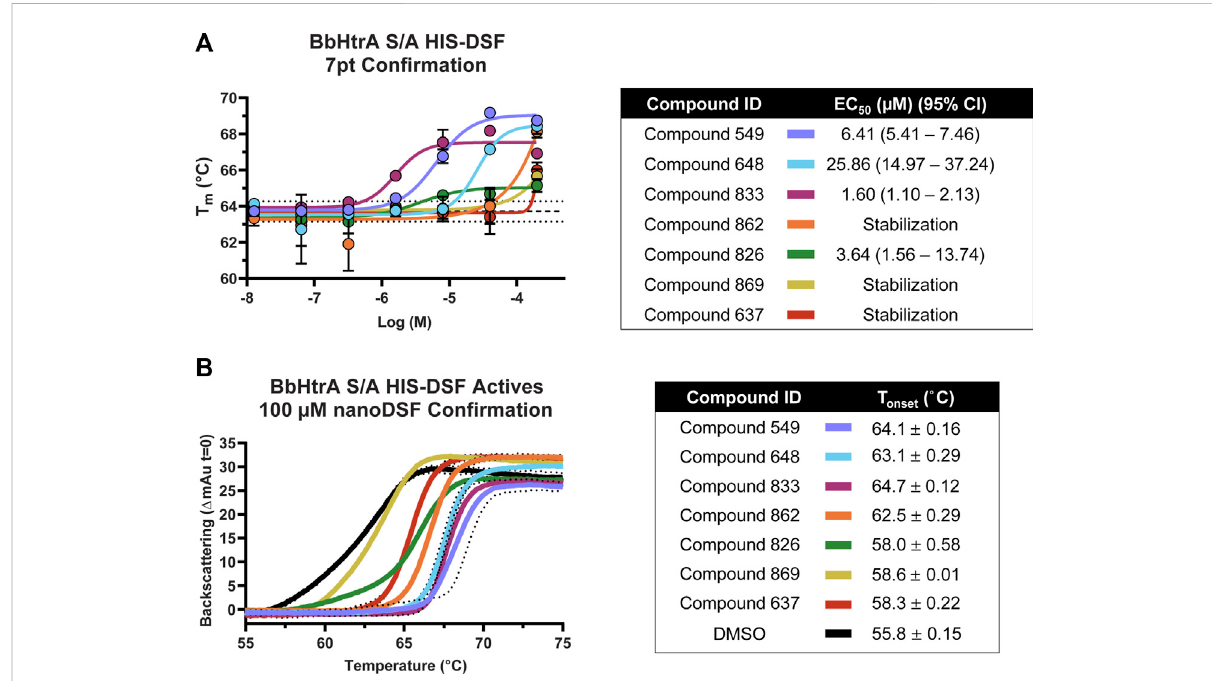
FIGURE 5 Con fi rmation and follow-up on the BbHtrA S/A hit molecules from the HIS-DSF primary screen. (A) Dose-response curves for the compounds that validated from the primary screen. Each point shown is the mean for fi ve replicates at an individual concentration, with error bars representing the standard deviation of the replicates. The dose-response values were fi t with a four-parameter log-logistic fi t to derive the EC 50 and 95% con fi dence interval. (B) Single dose stabilization as detected by nanoDSF for the 7 compounds that con fi rmed by dose-response HIS-DSF. The lines represent the mean backscattering signals for 3 replicates, with dotted lines representing the standard deviation of the